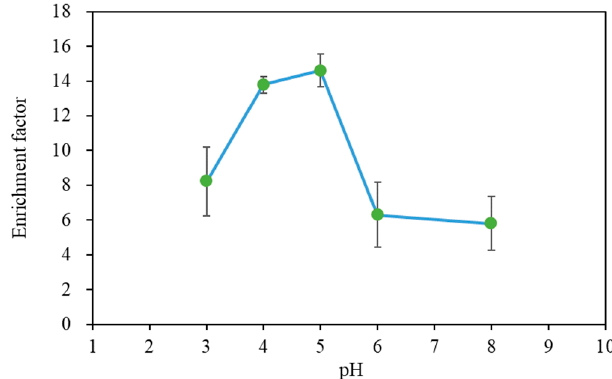
Figure 1. Effect of pH on the enrichment factor for Pb with magnetite Fe 3 O 4 . Sample: Pb 1 ng·mL − 1 , 100 mL; sorption time (magnetic stirring time): 30 min; magnetic stirring desorption: 0.1 mol·L − 1 HNO 3 1 mL.